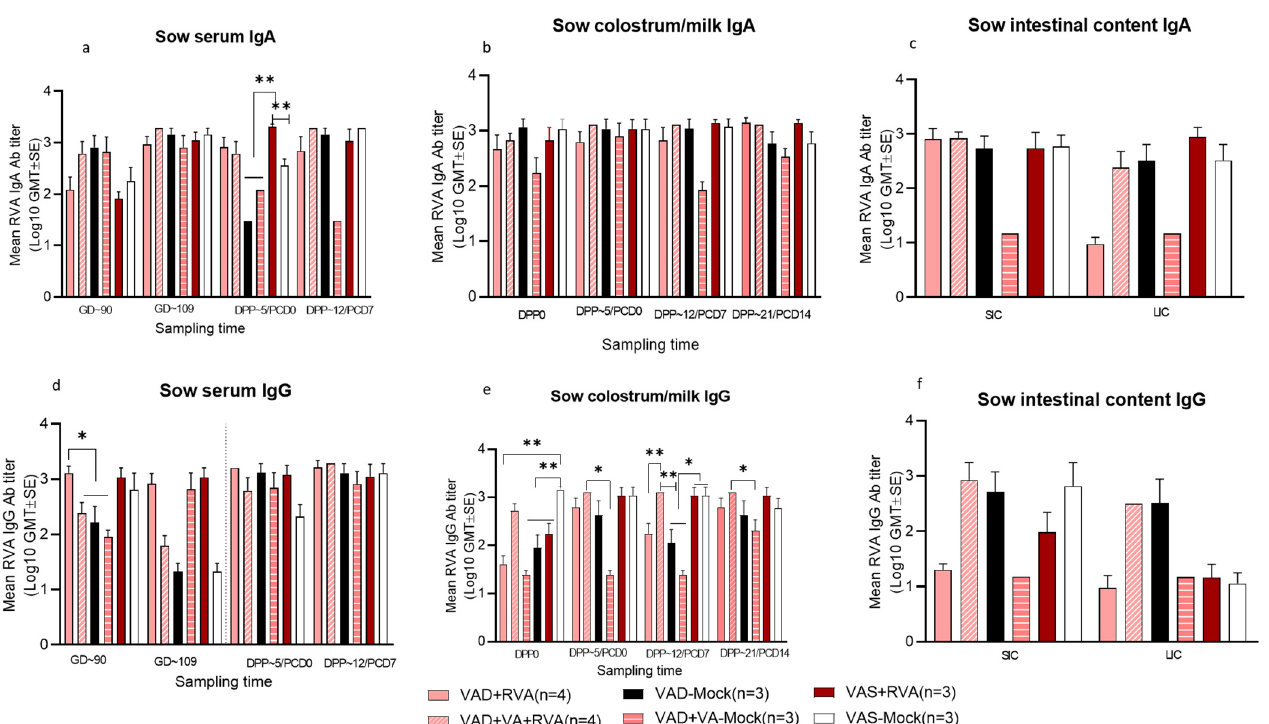
Figure 5. Mean RVA specific IgA antibody titers ( a – c ) and mean RVA IgG antibody titers ( d – f ) in serum, milk and intestinal contents (SIC/LIC) of RVA/mock inoculated sows fed VAS, VAD ( ± VA) diets during gestation and lactation (* p < 0.05; ** p < 0.01). SIC—small intestinal contents, LIC—large intestinal contents.